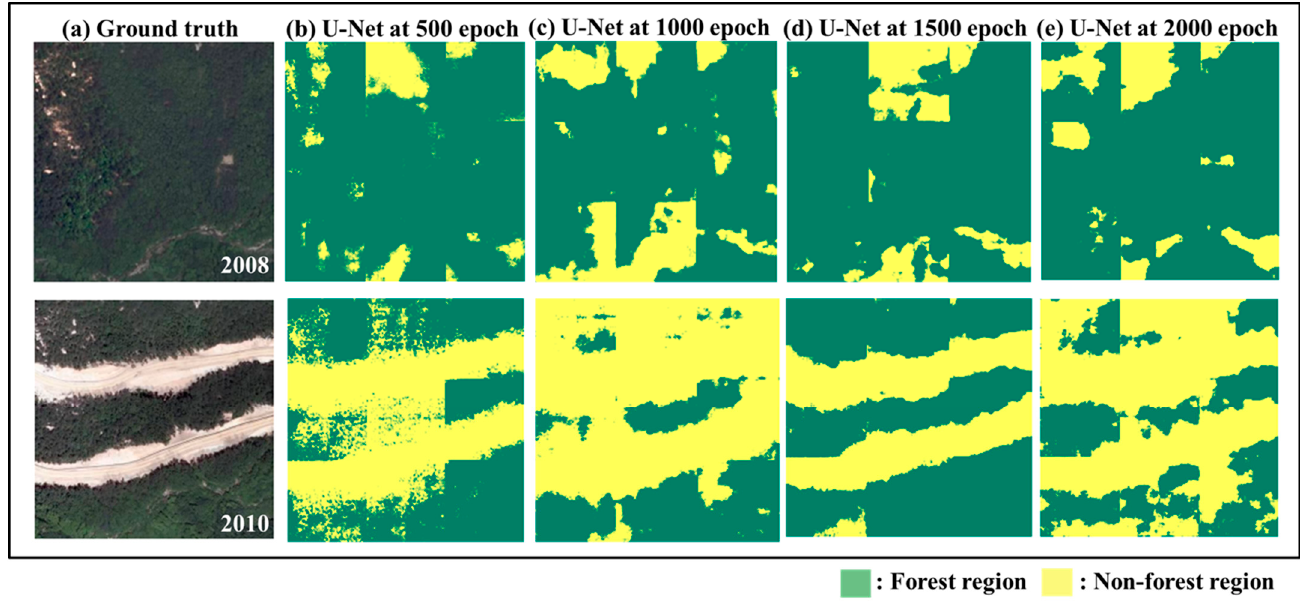
Figure 10. U-Net test performance of classifying forest and non-forest regions in different periods of Gangwon province with respect to: ( a ) ground truth, ( b ) 500, ( c ) 1000, ( d ) 1500, and ( e ) 2000 epoch, and green color denotes the forest areas while yellow indicates non-forest areas denoting to 0 and 1, respectively.